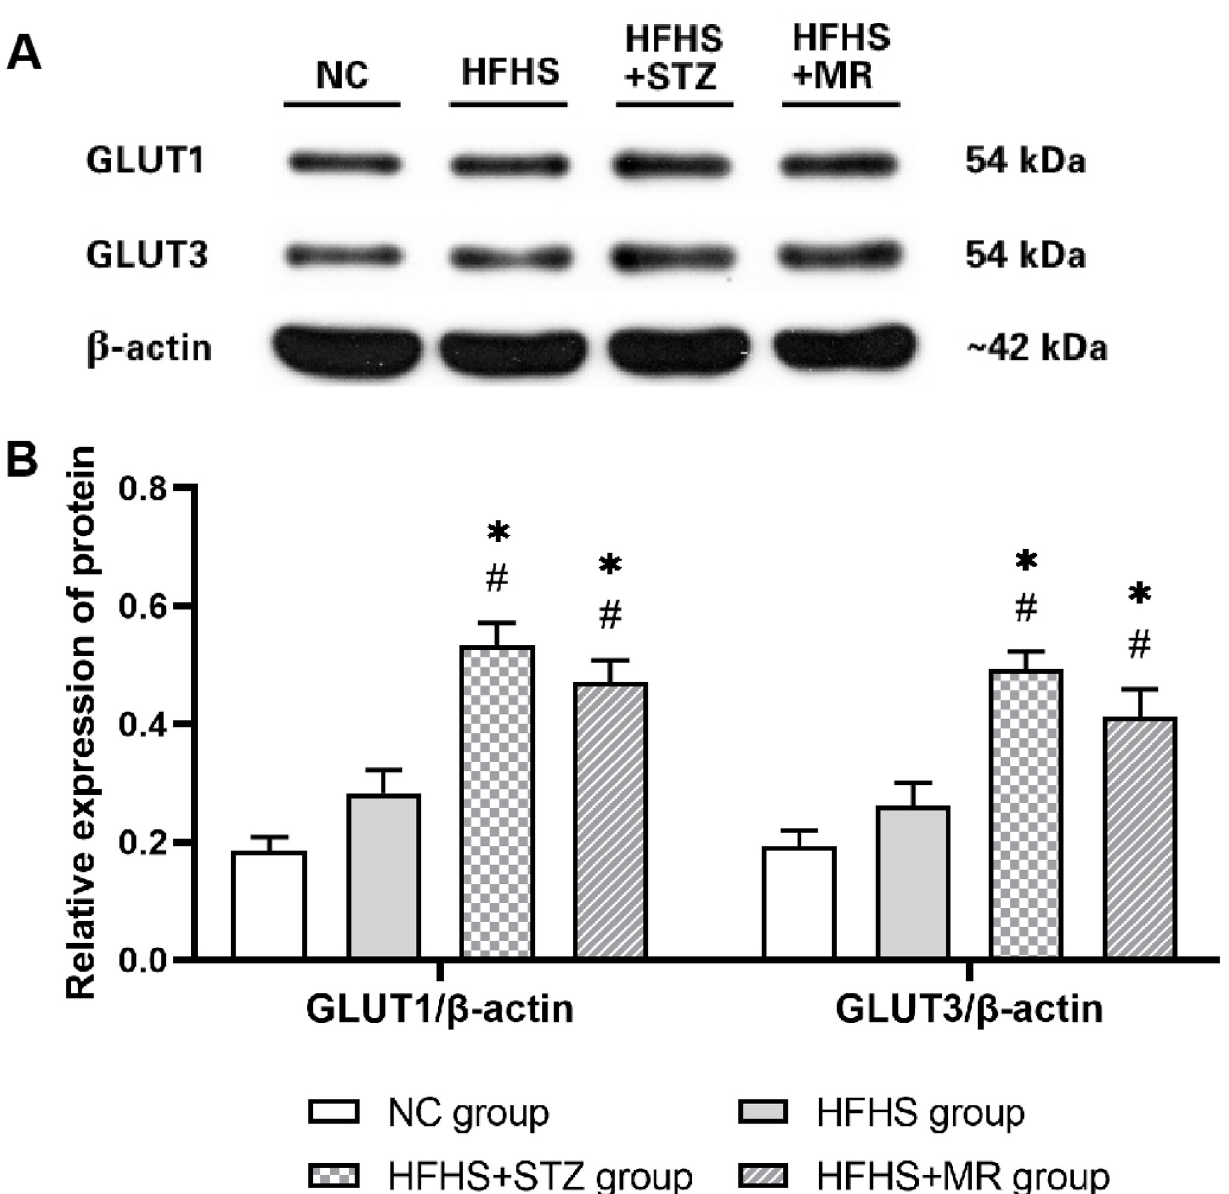
Fig 6. Protein expression levels of GLUT1 and GLUT3 in the four rat groups. (A) Effects on the protein expression levels of GLUT1 and GLUT3 and the internal reference β -actin as determined by Western blot analysis, (B) Comparison of the protein expression levels of GLUT1 and GLUT3. � P < 0.05 vs. the NC group; # P < 0.05 vs. the HFHS